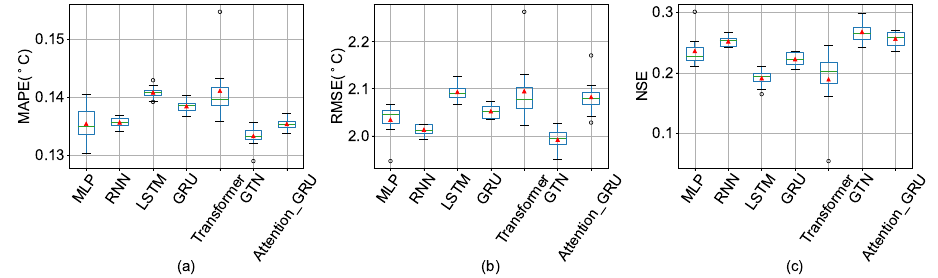
Figure A2. The box plot of ten experiment results of deep learning models under the mean filling. ( a ): The results of MAPE. ( b ): The results of RMSE. ( c ): The results of